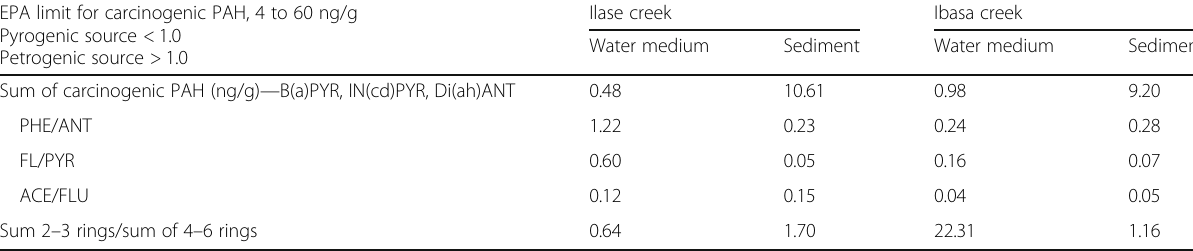
Table 6 Sources and carcinogenic potential of PAH residues in the water and sediment media in Ilase and Ibasa creeks, Snake Island, Lagos